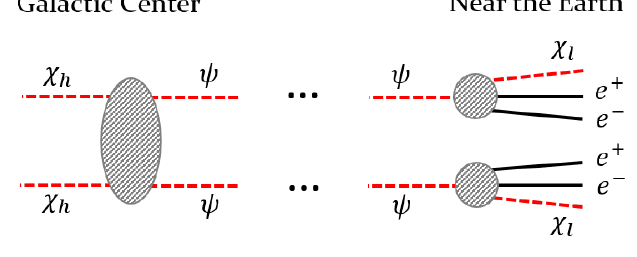
Figure 1 . A benchmark scenario for the positron